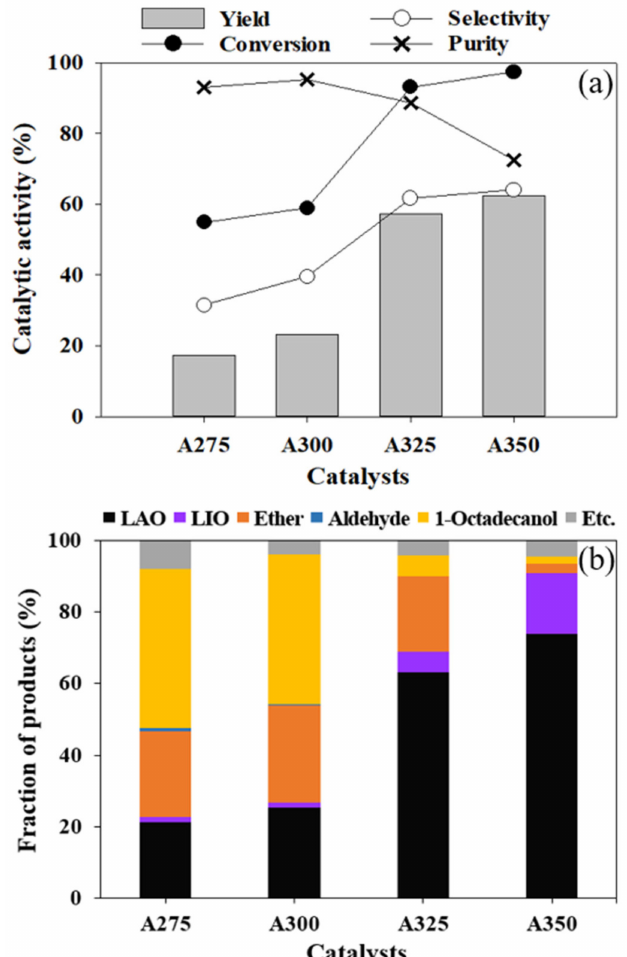
Figure 8. The results of 1-octadecanol dehydration ( a ) and product distribution after dehydration reaction of 1-octadecanol; ( b ) reaction condition: 2 h, 300 ◦ C, 500 rpm, N 2 15 bar, 1 g of 1-octadecanol, 0.1 g of catalyst, 20 mL of n-dodecane.